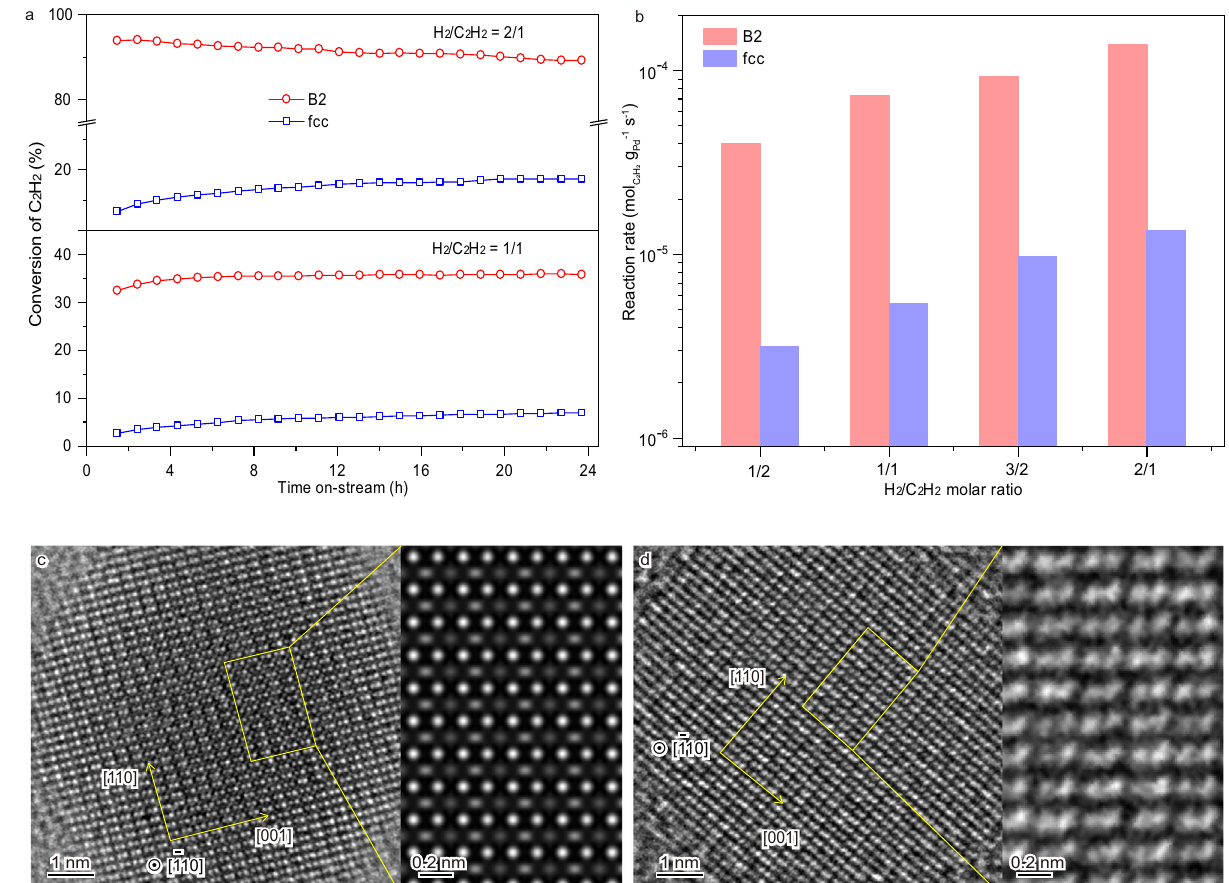
Fig. 5 | Acetylene hydrogenation over the PdCu particles. a Conversion of acetylene at the H 2 / C 2 H 2 molar ratios of 1/1 and 2/1 at 298K. b Reaction rate as ranging the H 2 /C 2 H 2 ratio from 1/2 to 2/1 at 298K. c A TEM image of a B2 particle underH 2 (1mbar)at303K;thesimulatedimageoftherectangularregionshowsthe dissociated H atoms (grey dots) sited between Pd and Cu atomic columns (bright